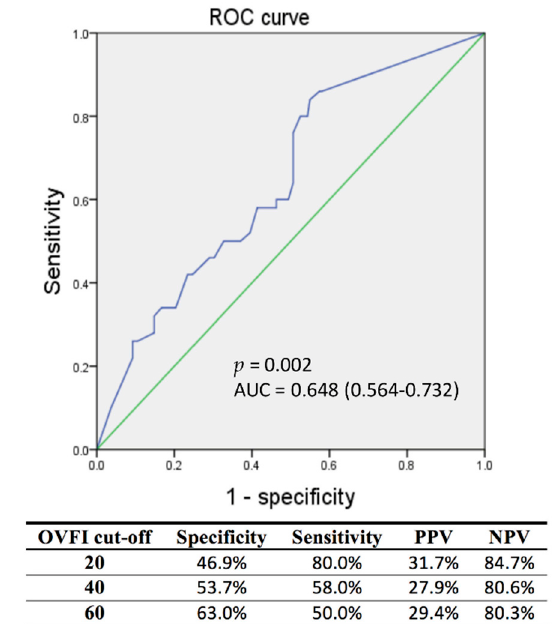
Figure 1. ROC analysis to determine sensitivity and specificity of OVFI for AT / AF episodes more than 4 h. AF, atrial fibrillation; AT, atrial tachyarrhythmia; AUC, area under the curve; NPV, negative predictive value; OVFI, OptiVol fluid index; PPV, positive predictive value; ROC, receiver operating characteristic.